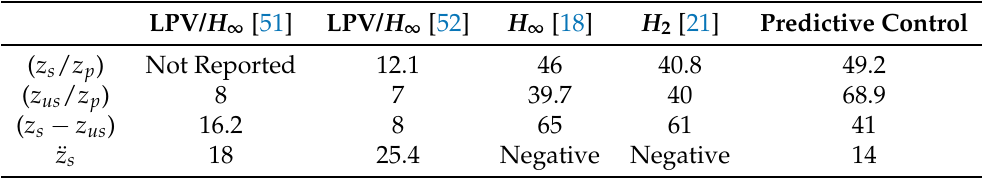
Table 4. Percentage of improvement of reported work and proposed predictive control strategy against passive case. Result are reported in frequency